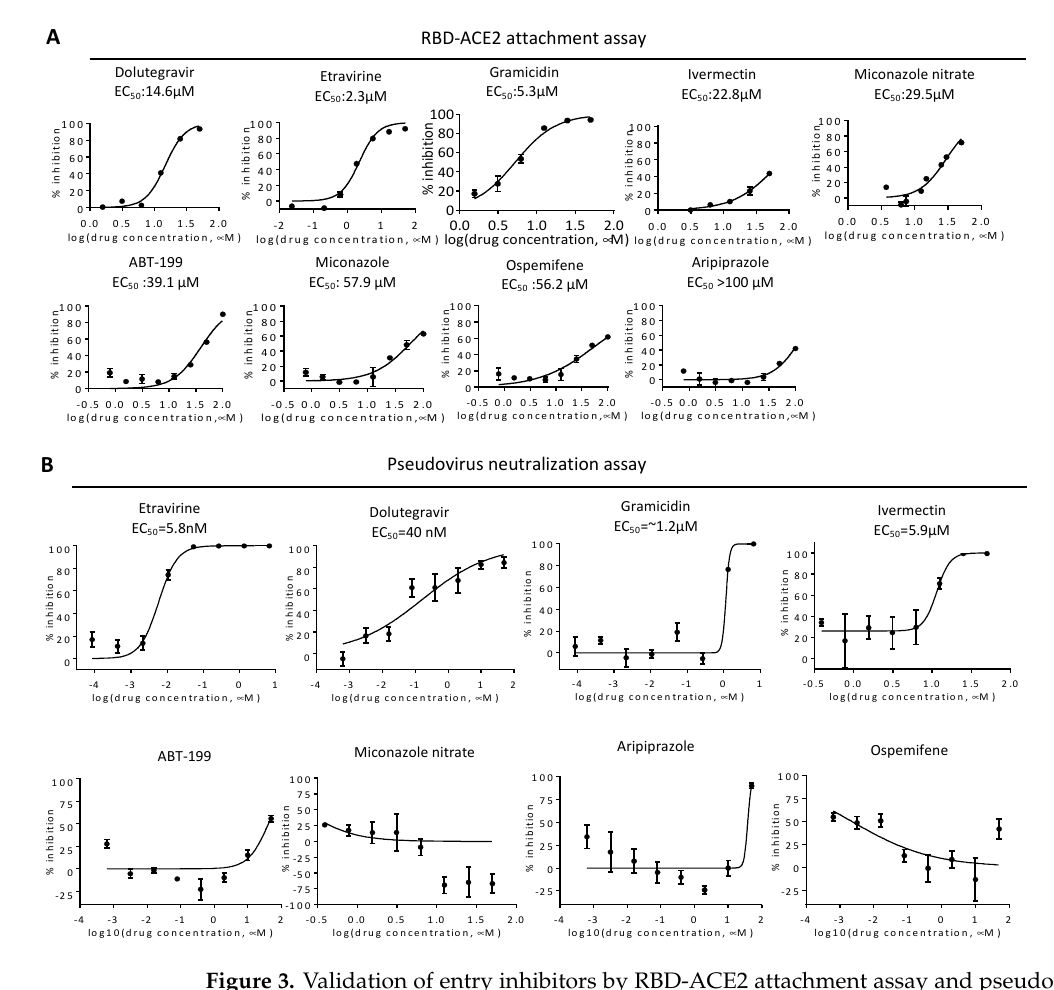
Figure 3. Validation of entry inhibitors by RBD-ACE2 attachment assay and pseudovirus neutralization assay. ( A ) EC50 of indicated drugs was determined by the RBD-ACE2 attachment assay. Mean and standard deviations from three technical replicates are shown. ( B ) HeLa cells expressing SmBiT-ACE2 were treated with entry inhibitors upon infection with spike-based pseudovirus carrying NanoLuc reporter genes. Representative results of pseudovirus neutralization activity of in- dicated entry inhibitors are shown. Inhibitor concentrations are presented in log scale for logarithmic interpolation. EC50 values of entry inhibitors in the neutralization assay are shown as indicated. Table 2. Summary of candidate entry inhibitors identified in this study.